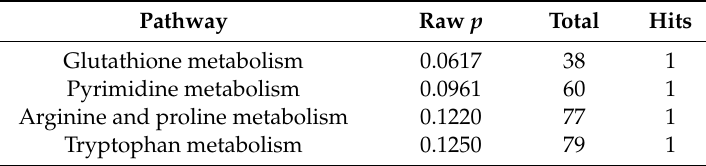
Figure 6. Biomarker identification and altered metabolic pathways regulated by BA-12. For GC–MS metabolomics: ( A ) score plots of control (C group, PBS) and BA-12 (B group, 2.5 µ M) from principal component analysis (PCA) for principal component 1 (PC1) versus PC2; ( B ) score plots of control (C group, PBS) and BA-12 (B group, 2.5 µ M) from orthogonal projections to latent structures discriminant analysis (OPLS-DA) model for the pairwise comparisons; ( C ) S-plot of the OPLS-DA model for the B and C groups. The points in red indicate the identified biomarkers. For UPLC–TOF-MS metabolomics: ( D ) score plots of control (C group, PBS) and BA-12 (B group, 2.5 µ M) from PCA in the positive electrospray ionization (ESI + ) mode for PC1 versus PC2; ( E ) score plots of control (C group, PBS) and BA-12 (B group, 2.5 µ M) from OPLS-DA model for the pairwise comparisons; ( F ) S-plot of the OPLS-DA model for the B and C groups. The points in red indicate the identified biomarkers. Table 3. Altered metabolic pathways regulated by BA-12 based on GC–MS metabolomics. 2.5